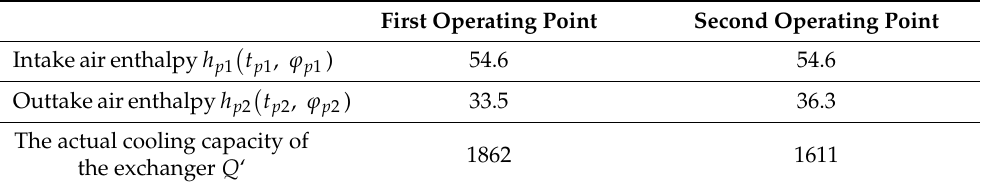
Table 5. Calculations of heat exchanger efficiency from the air